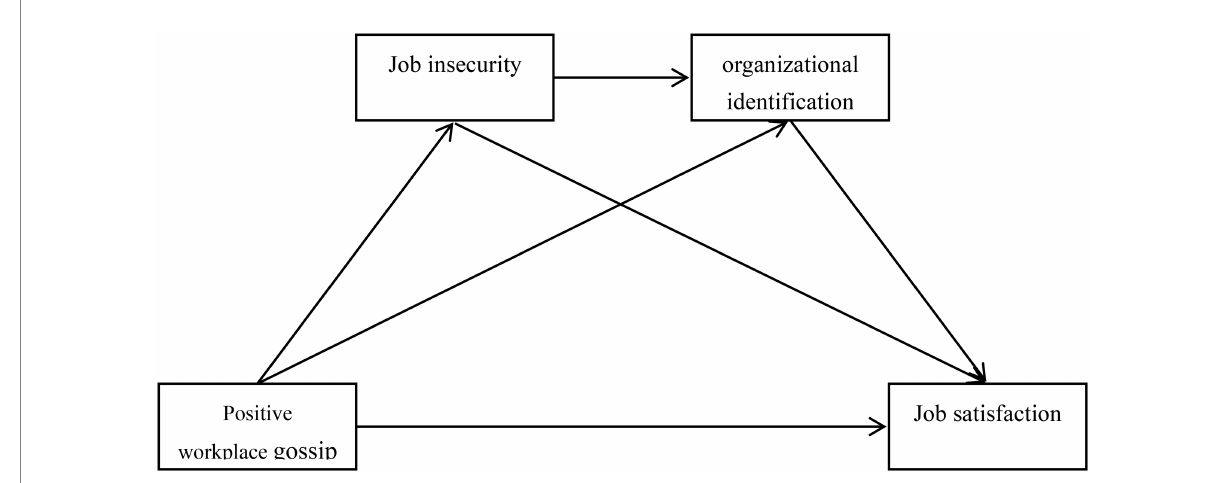
FIGURE 1 Serial mediating model of positive workplace gossip and job